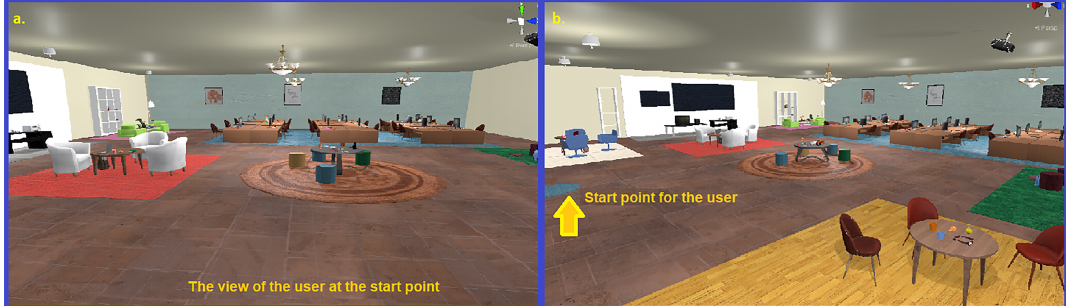
Figure 3. Screenshots showing two views of the office: ( a ) the view of the office from the perspective of the user at the beginning; ( b ) Another view of the office.